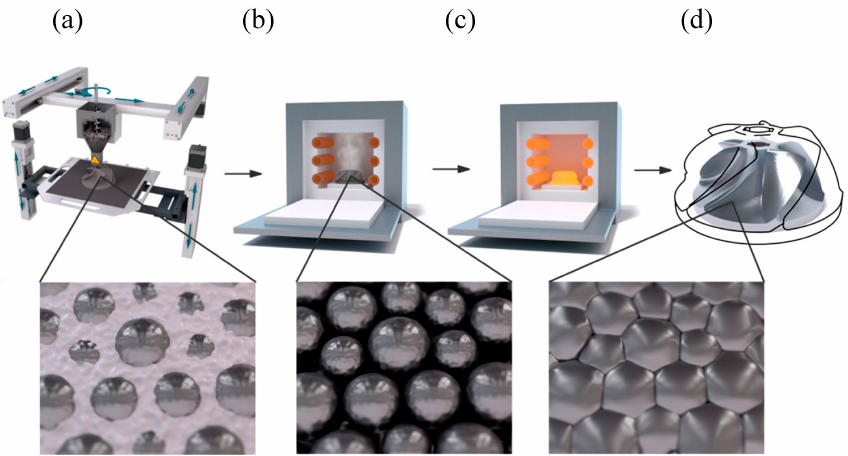
Figure 1. Composite extrusion modelling (CEM) process scheme: ( a ) 3D printing of the greenpart using a CEM printer with small-sized extruder; ( b ) debinding of the greenpart in a debinding furnace; ( c ) sintering of the resulting brown part in a high-temperature furnace; ( d ) final metal part. The modification of the material structure is illustrated in the pictures below: metal injection moulding (MIM) granule with metal particles in a thermoplastic matrix (left), porous brown part (middle), densely sintered metal part (right).